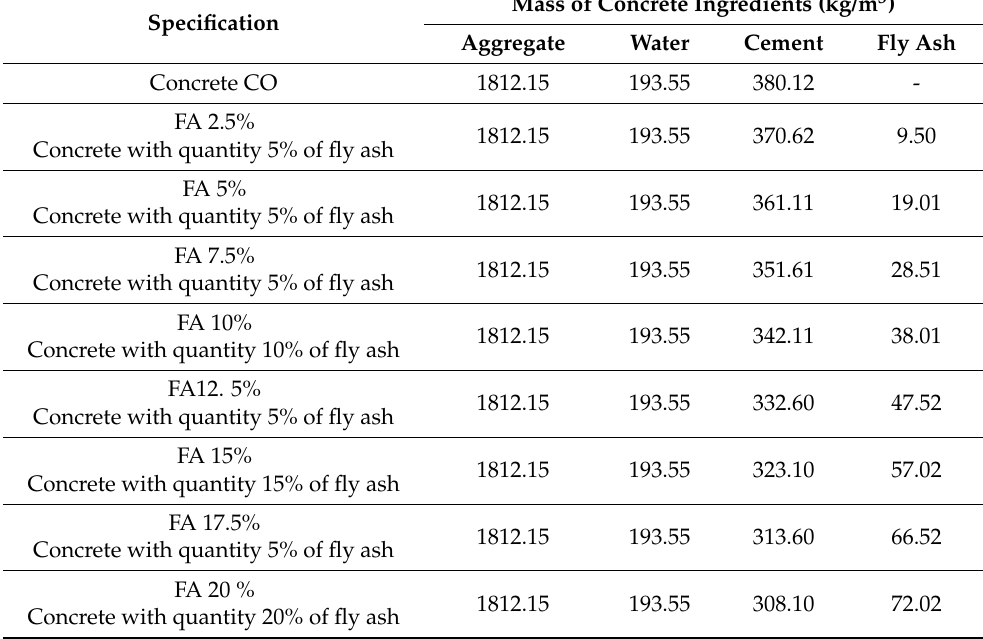
Table 4. Concrete mix proportions by weight.